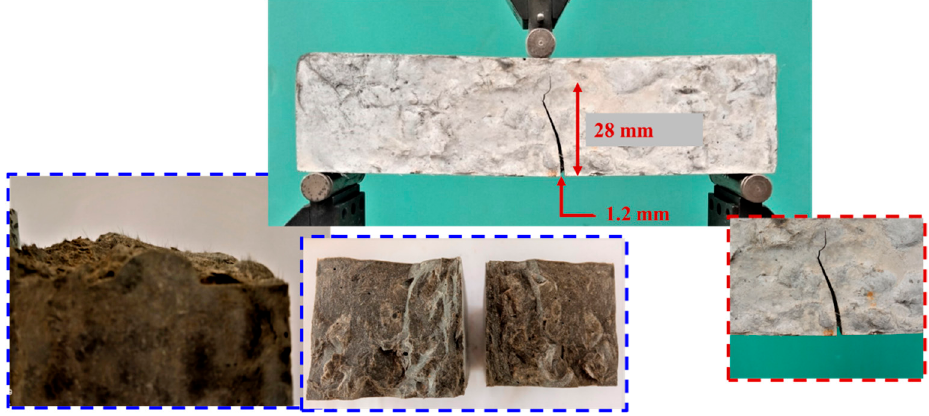
Figure 16. Crack width and length after three-point bending test and CFs concentration at the rupture interface in the case of simple dry mixing of CFs with SP addition.